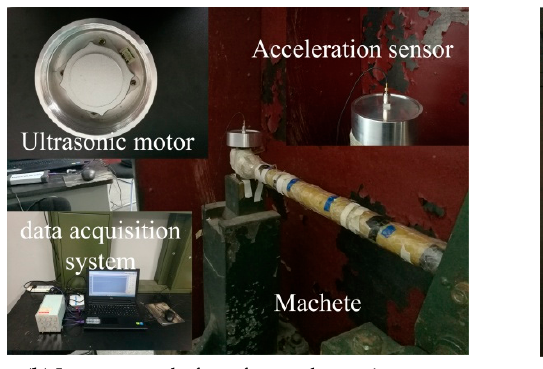
Figure 9. Experiment test platform.